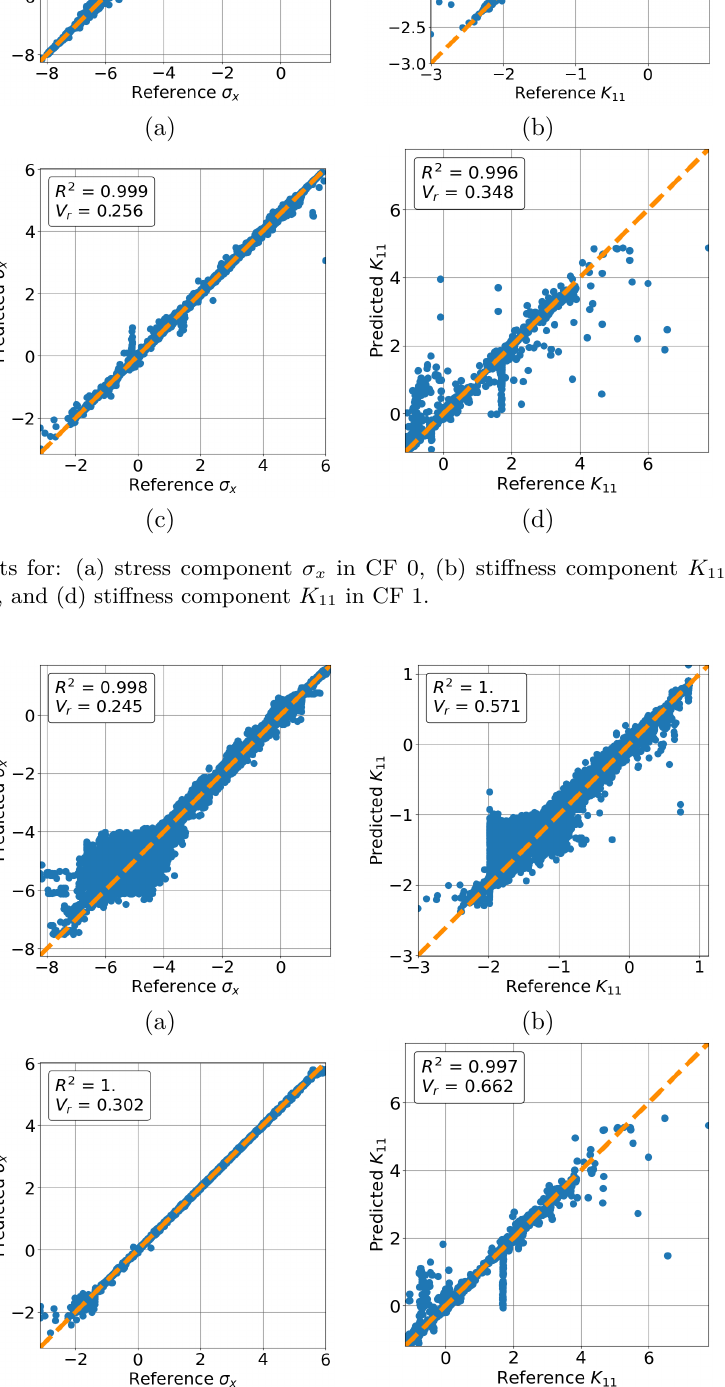
in CF 0, (b) stiffness component K x in CF 11